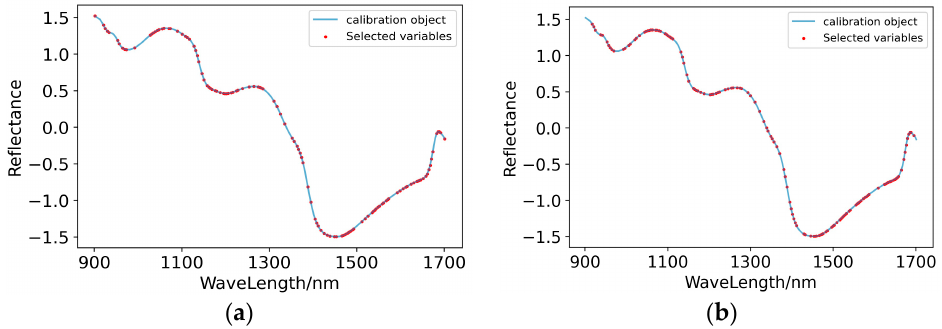
Figure 16. Characteristic wavelengths’ distribution of prediction models for the content of potassium in pear peel. ( a ) SNV-GA-PLSR; ( b ) SG+SNV-GA-PLSR. (3) Modelling of characteristic wavelengths